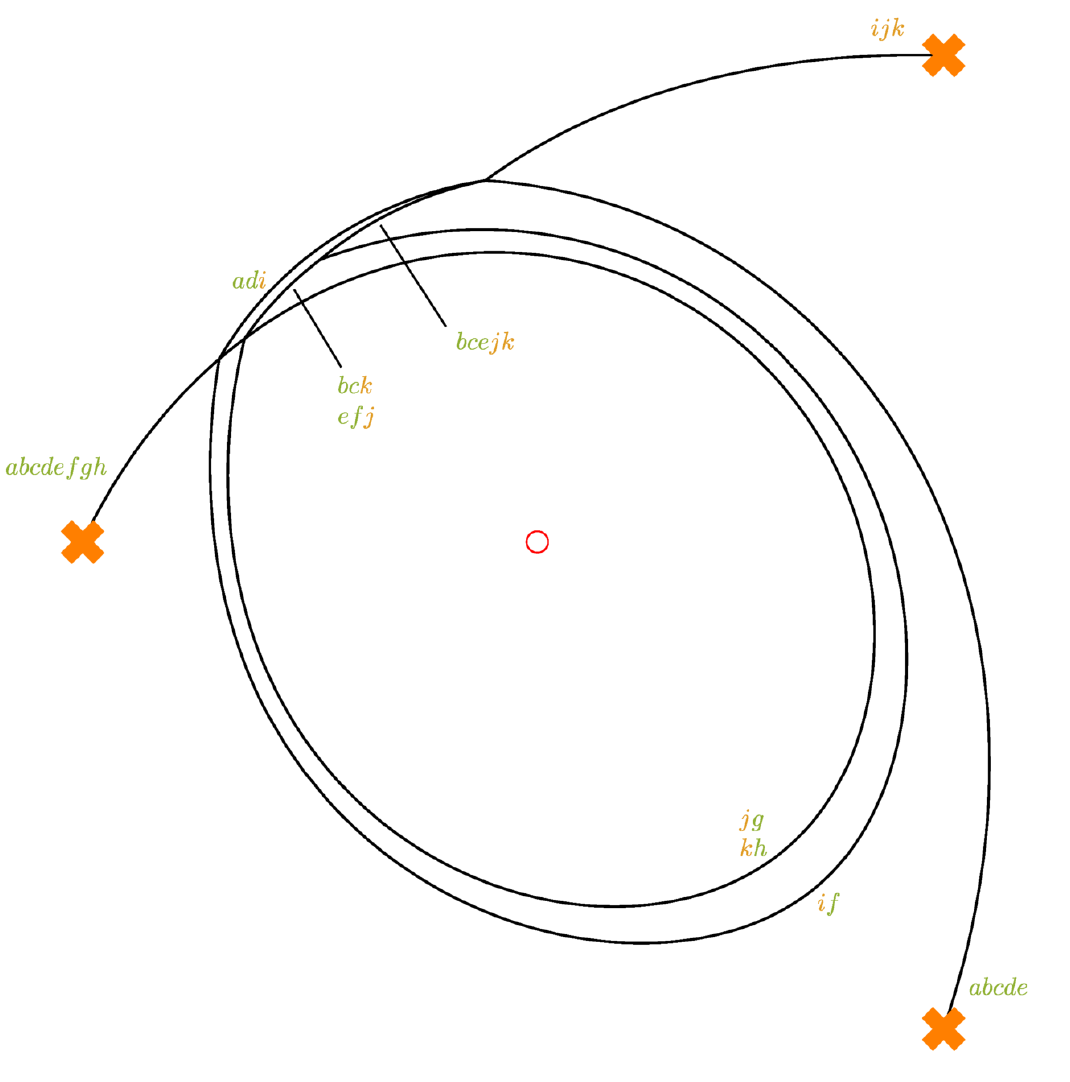
Figure 43. The (cid:12)nite web for the dimension (3 ; 8)